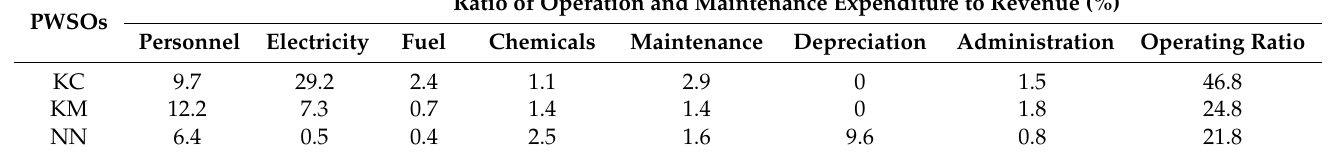
Table 5. The ratio of operation and maintenance expenditure to revenue in 2020.